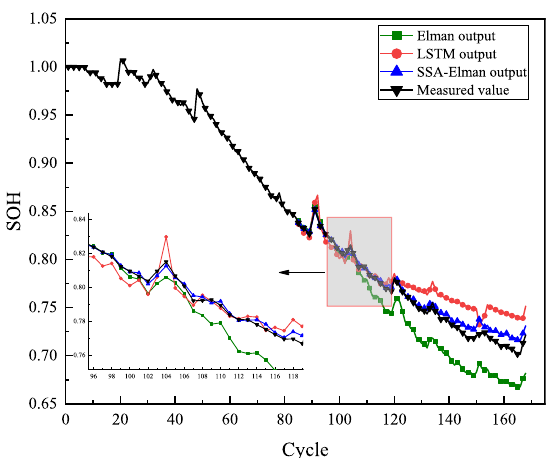
Fig. 13 The outputs of SSA-Elman, BP, Elman and LSTM when using 50% training data